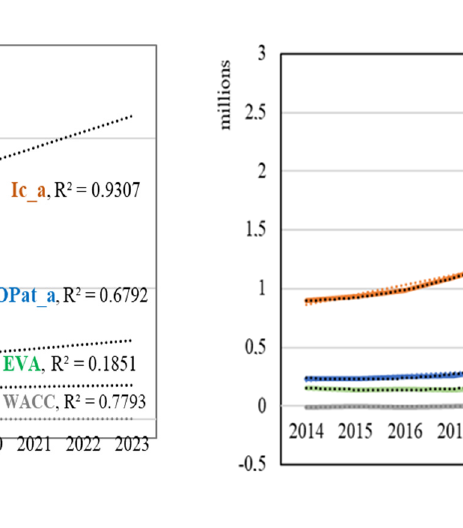
Figure 1. The impact of the variation of economic added value (EVA) determinants (compound annual growth rate (CAGR) [%]). Source: Authors own representation.